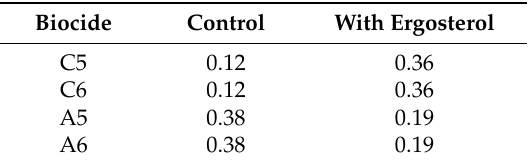
Table 4. Effect of exogenous ergosterol on MICs of cationic and neutral gemini surfactants for A. brasiliensis conidia.